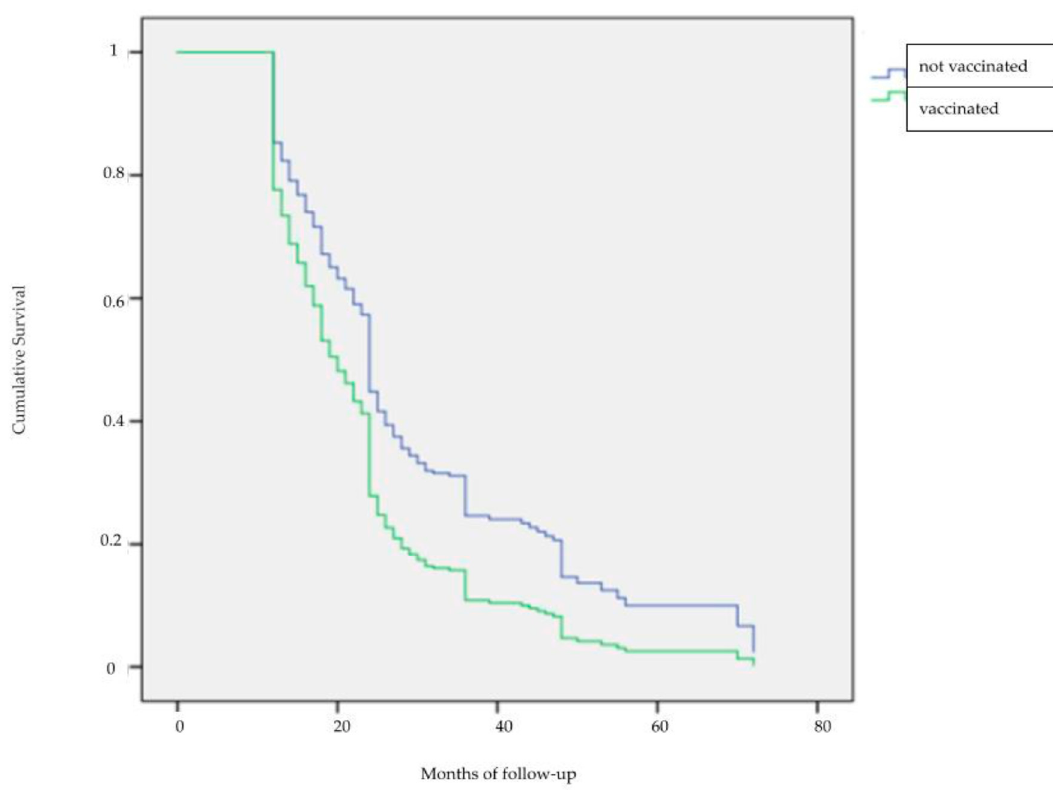
Figure 2. Graphical Representation of time to negativity during follow-up.